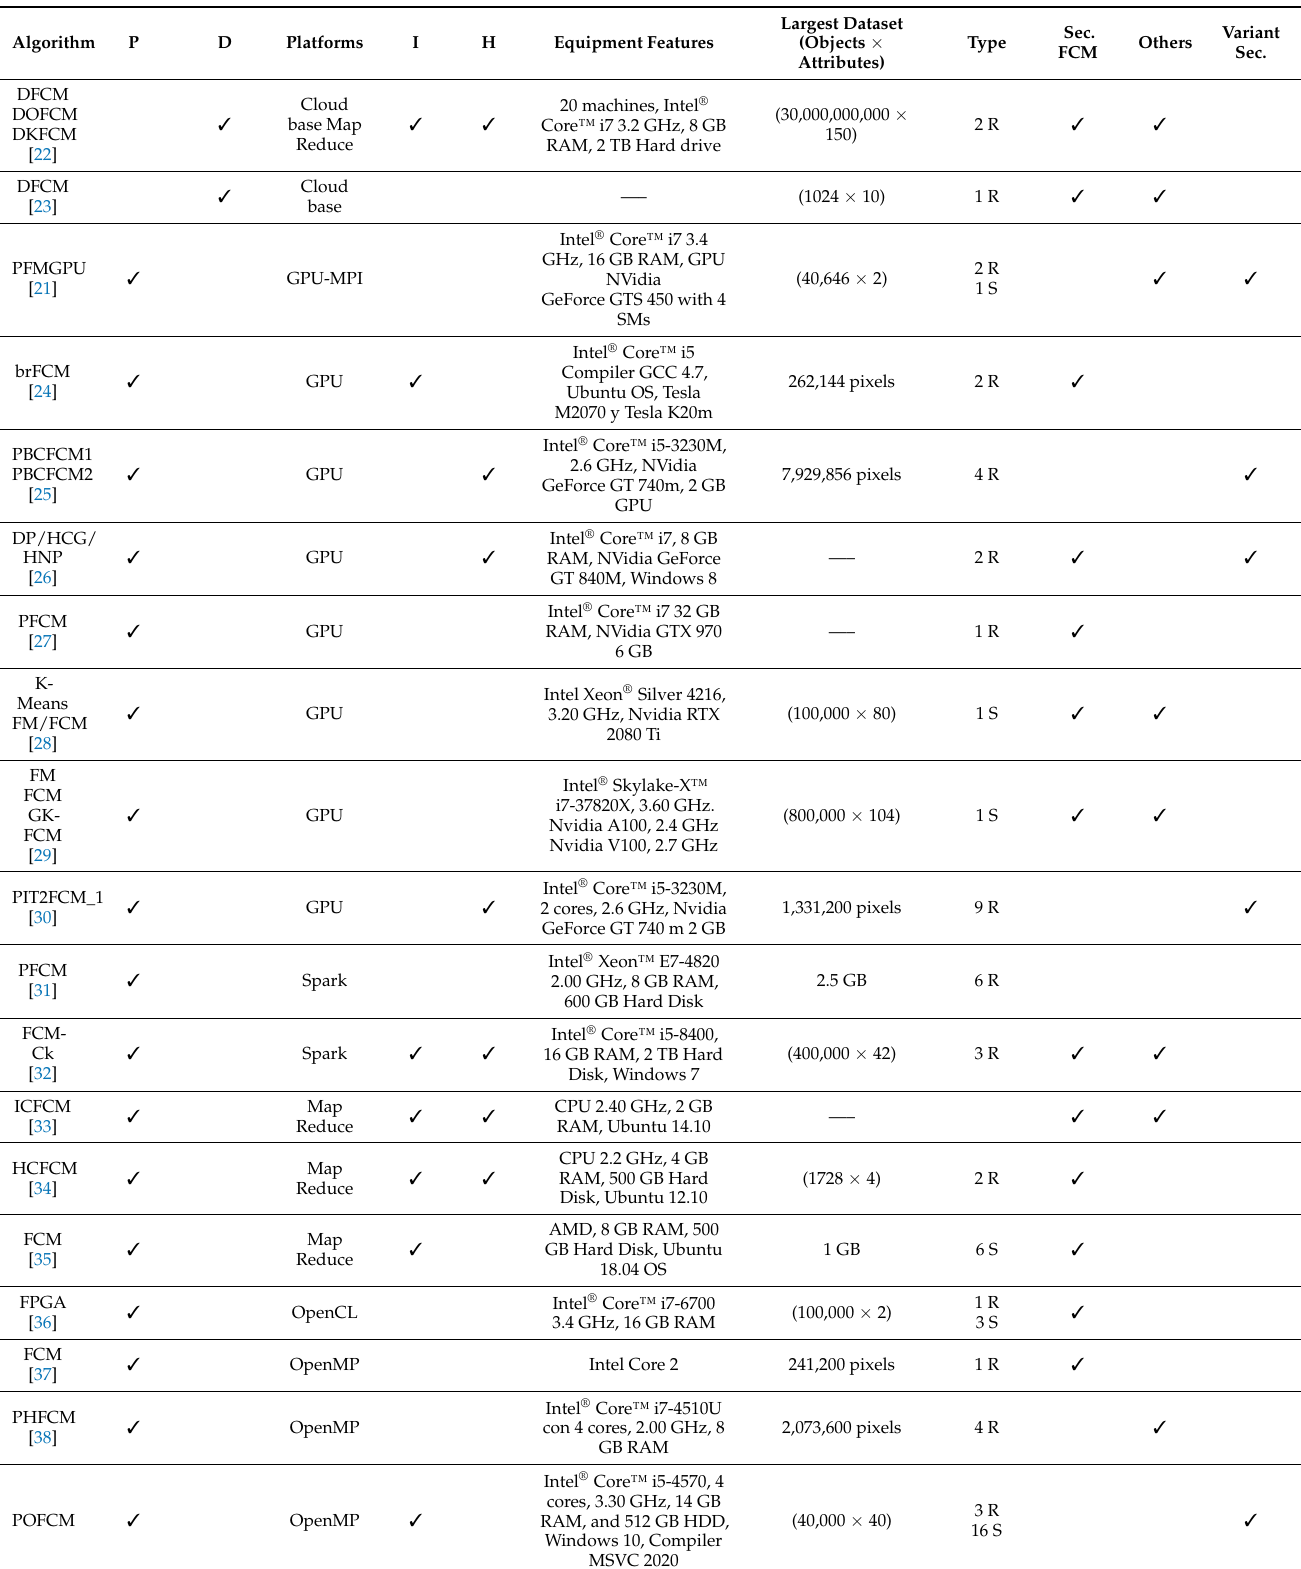
Table 1. Comparison of recent parallel FCM clustering